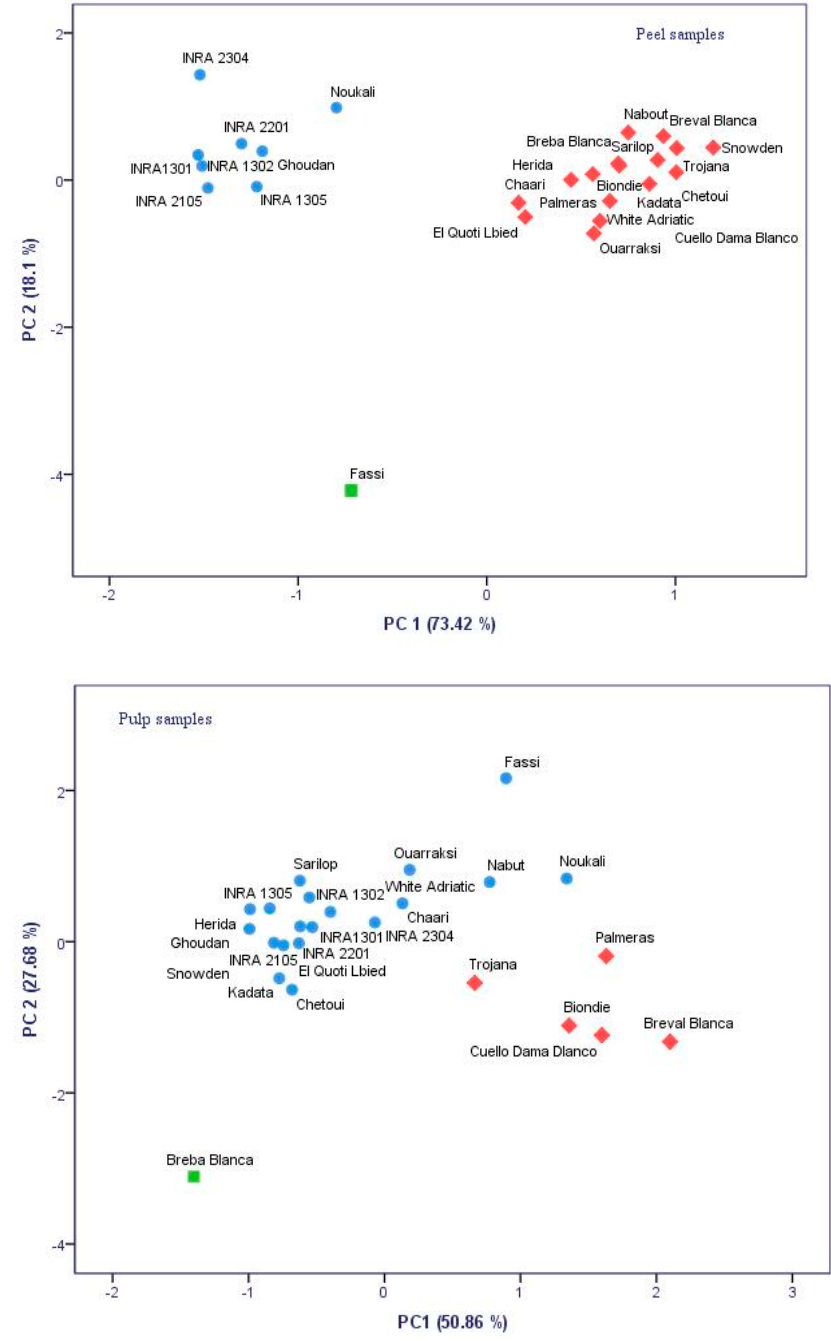
Figure 1. Principal component analysis ( PCA) two-dimensional scatter plots based on the first two principal components (PC1 and PC2) generated for 25 cultivars based chromatic coordinates color of figs’ peels and